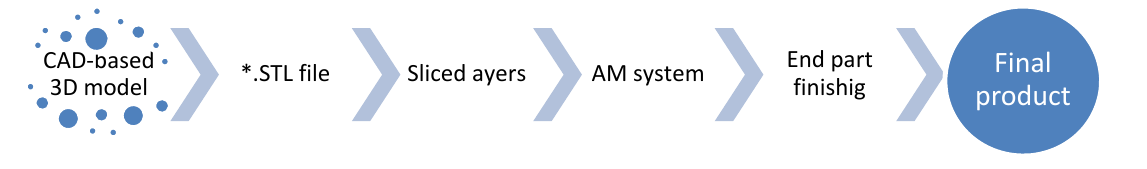
Figure 10. Additive manufacturing